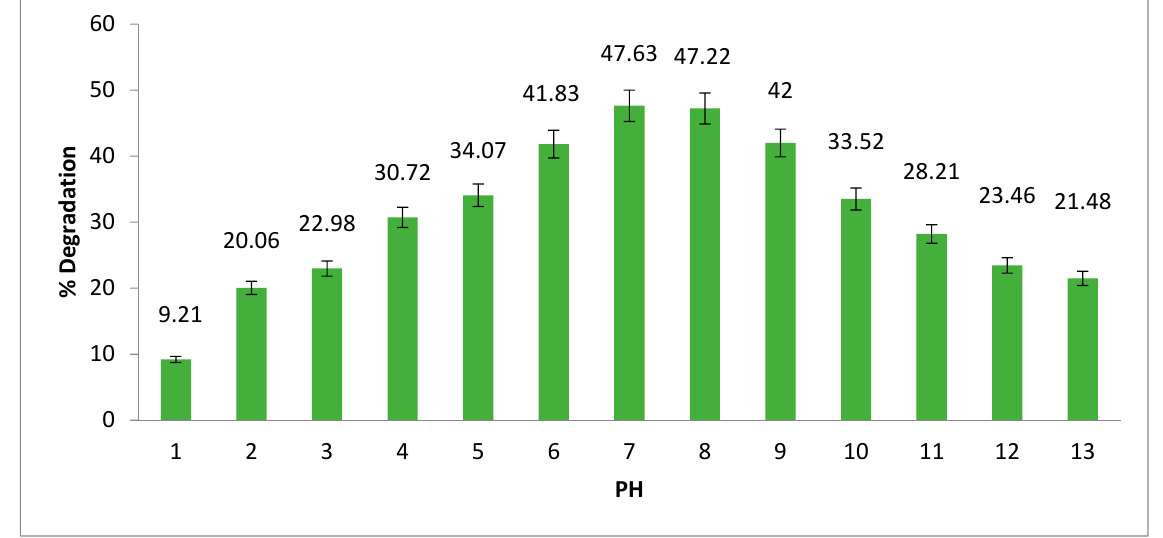
Figure 4. Effect of pH on % degradation of brown 706.